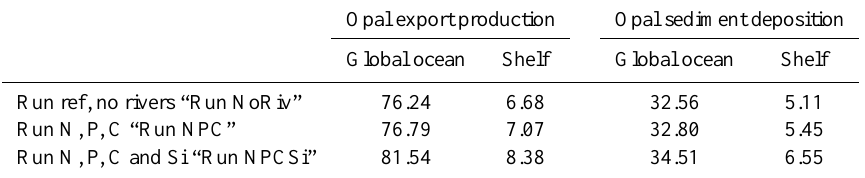
Table 3. Model runs and opal production budgeting (TmolSiyr − 1